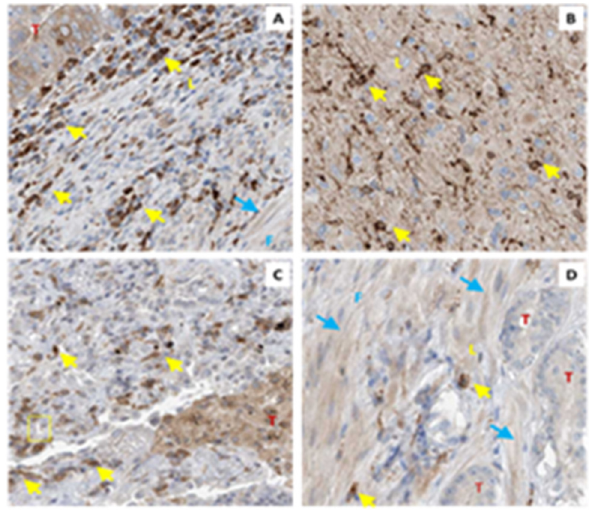
Figure 6. TXA 2 S is Expressed in Tumor Stroma . Biopsies from colorectal ( A ) brain ( B ), lung ( C ) and prostate ( D ) cancer were immunostained with antibodies against TXA 2 S. Tumor (T), leukocytes (L, ← ) and fibroblasts (F, ) all stain positively. Data are from the human protein atlas.